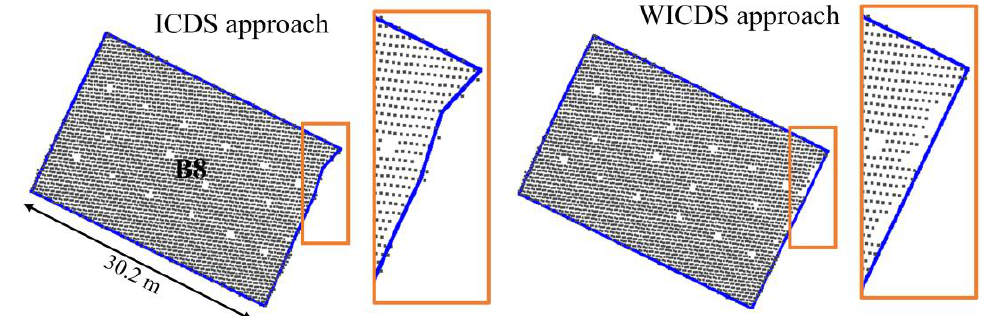
Figure 12. Modeled boundary for building B8. Results using the ICDS and WICDS method. The orange rectangles highlight the occlusion region.